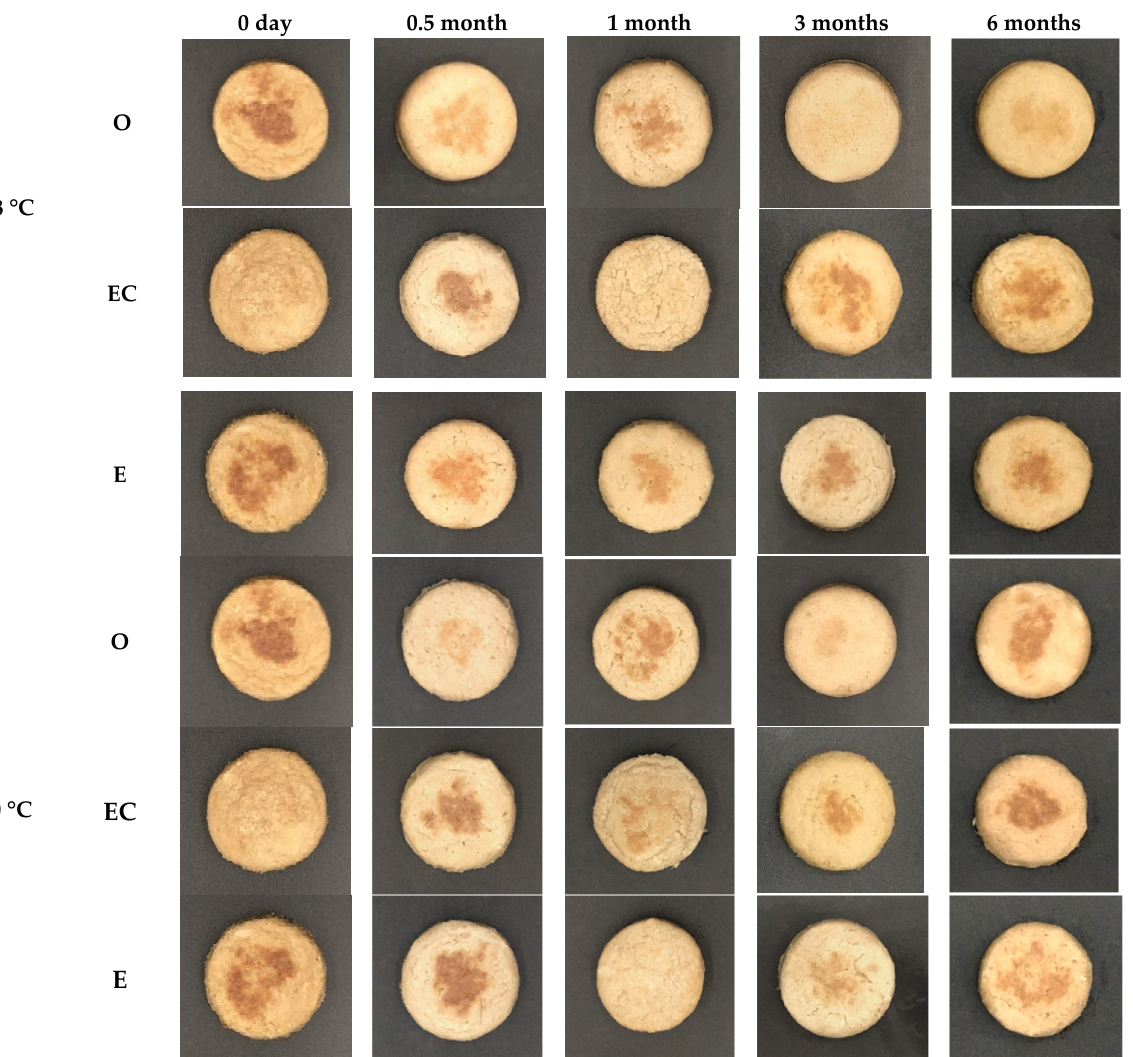
Figure 1. Appearance of meat analogs with different fat replacers (O, EC and E) during the freezing storage ( − 18, and − 60 °C) for six months. Table 2. Color of meat analogs with different fat replacers (O, EC, and E) during the freezing storage ( − 18 °C, − 60 °C) for six months.